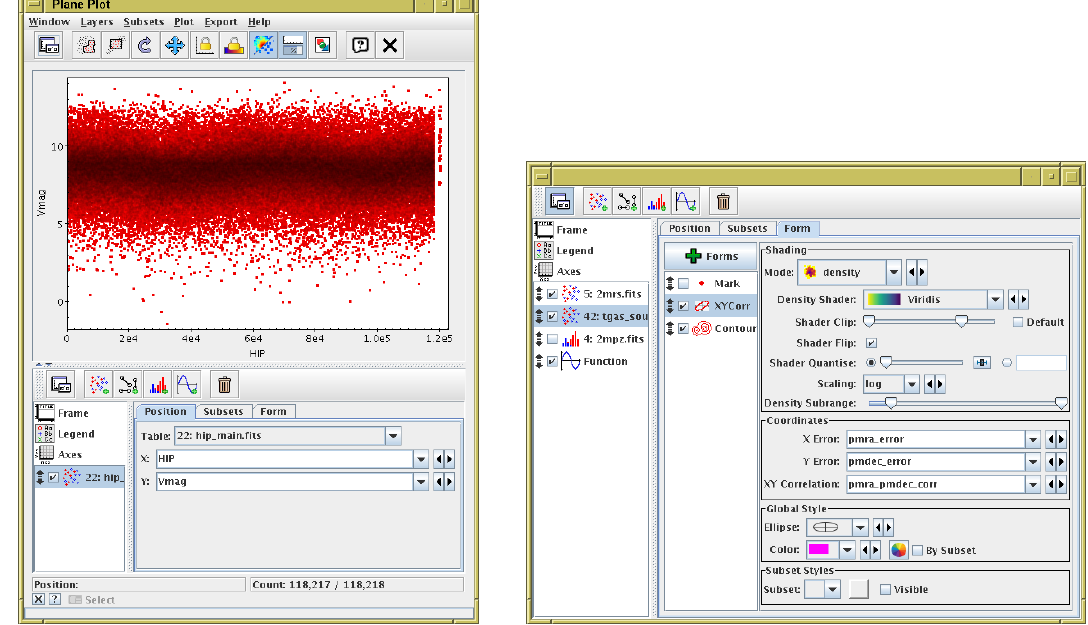
Figure 7. TOPCAT’s Plane Plot window. The left hand panel is what appears as soon as the user opens the window; some default plot is displayed. It is easy to see how to change the data to be plotted. The right hand panel shows the control panel from the bottom of the plot window (here it has been expanded and floated out into its own window), as configured for controlling a much more complicated plot. Each of the controls towards the right can be adjusted interactively with instant effects on the displayed plot. The various tabs and list items provide more configuration options for other aspects of the